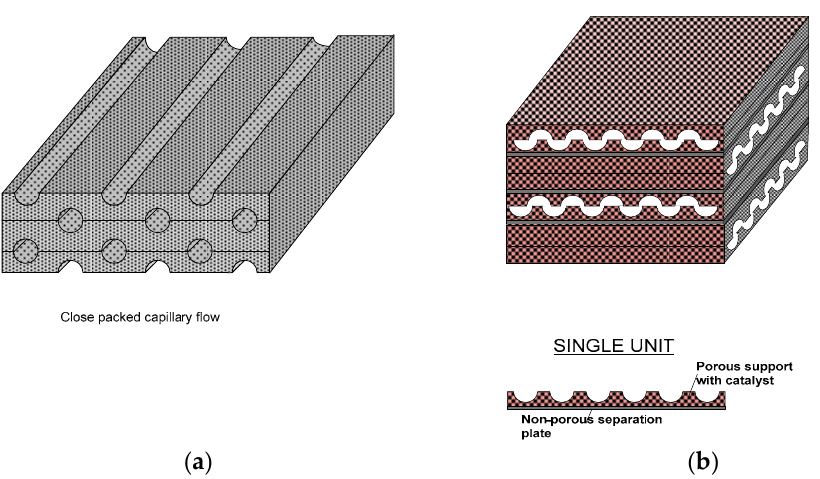
Figure 6. Various micro ‐ capillary reactors formed by macro ‐ porous metal foams filled with supported catalysts.